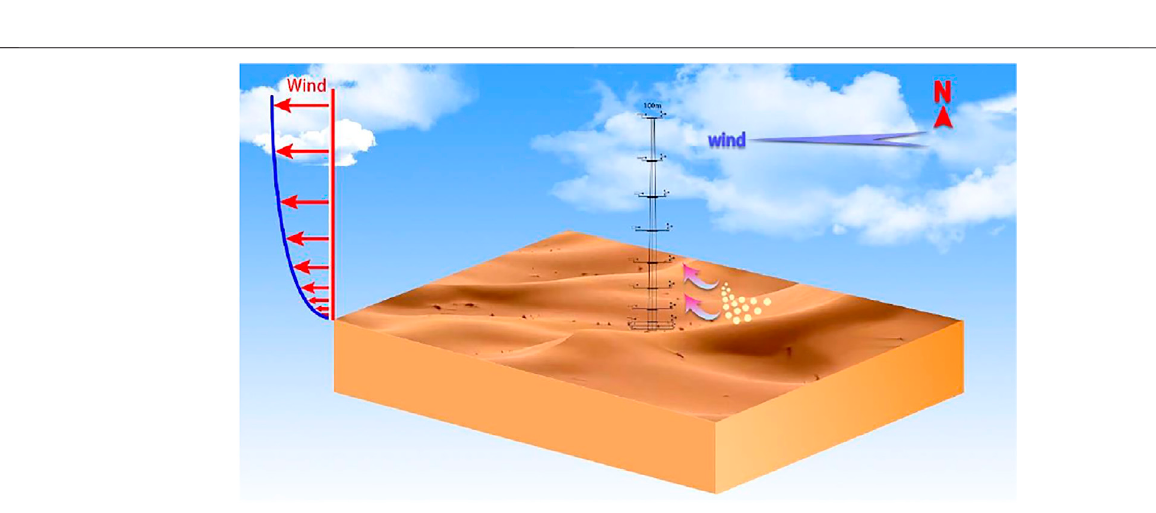
Frontiers in Environmental Science |